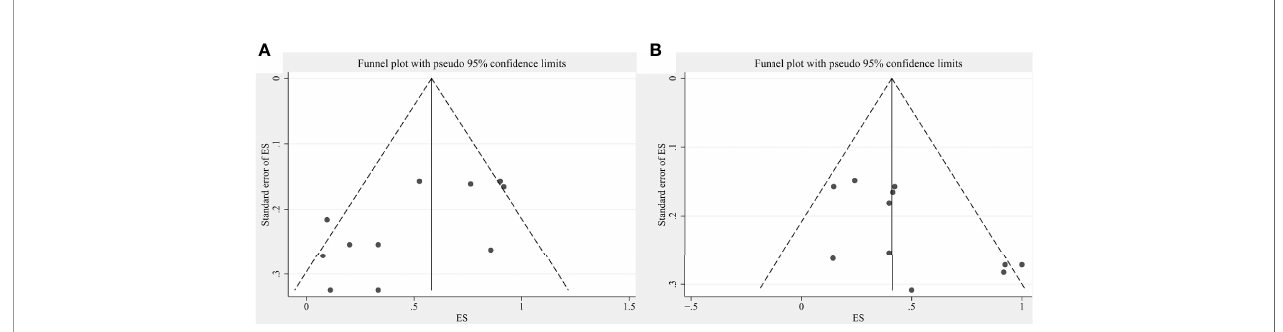
FIGURE 7 | Funnel plots showing publication bias for (A) ORR pooled analysis and (B) fever rate pooled